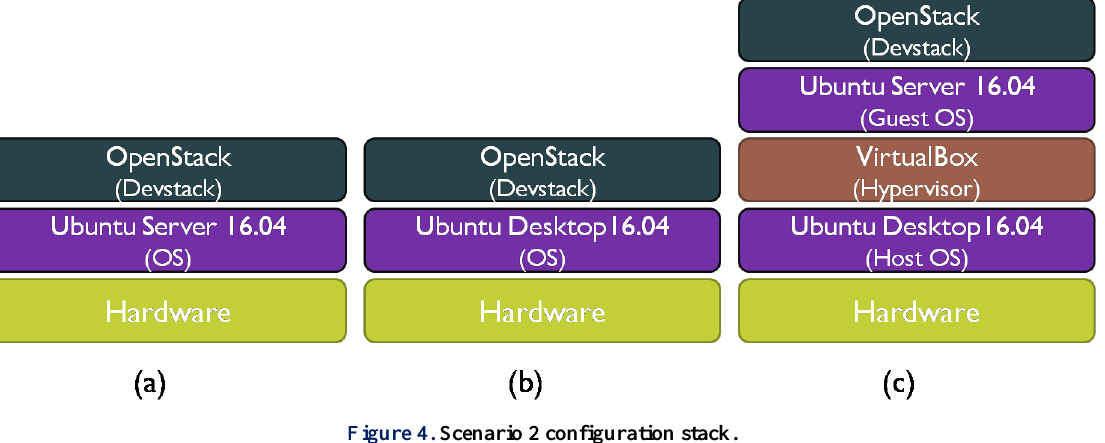
Figure 4. Scenario 2 configuration stack.